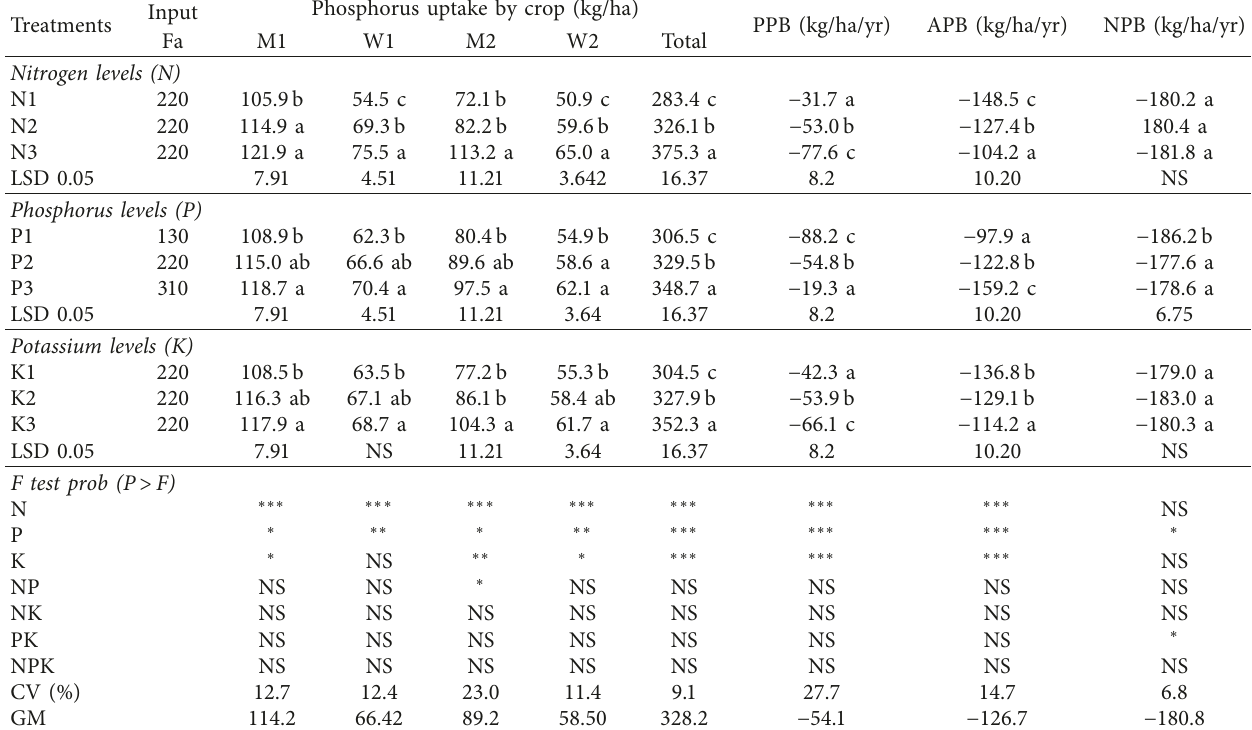
Table 4: Partial balance, apparent gain or loss, and net gain or loss of phosphorus per year as affected by fertilization in the maize-wheat experiment, Khumaltar, Lalitpur, 2019/20–2020/21.